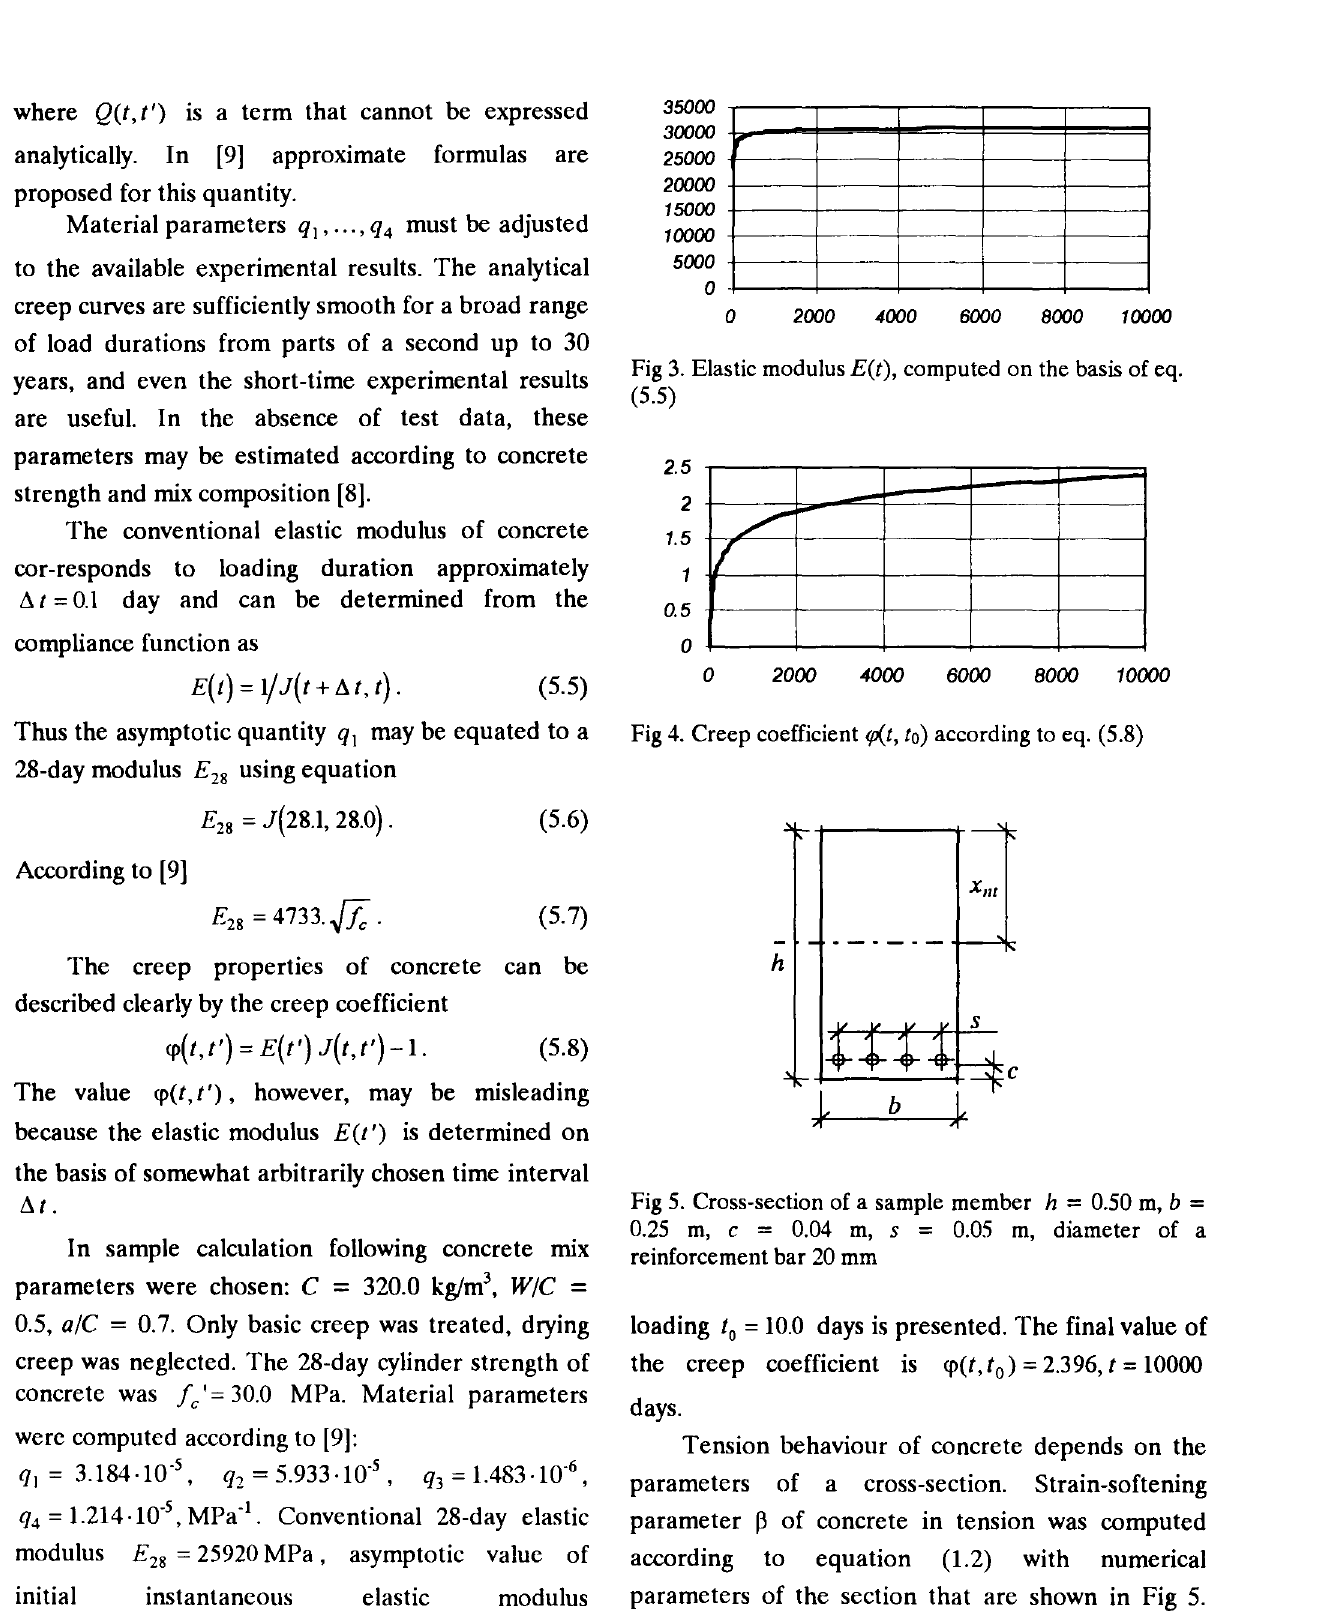
Fig 5. Cross-section of a sample member h = 0.50 m, b